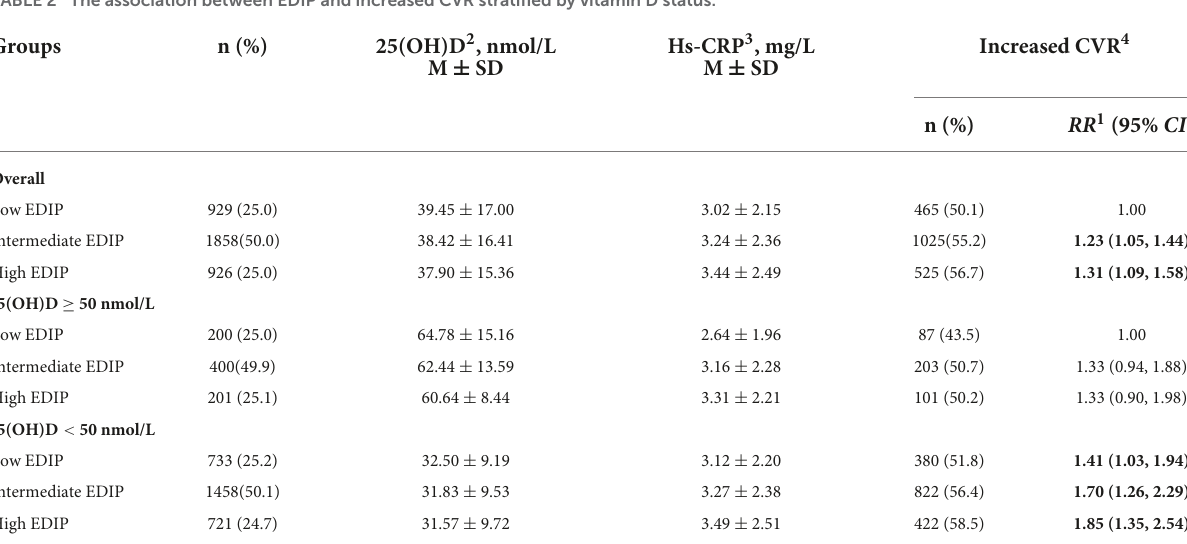
TABLE 2 The association between EDIP and increased CVR stratified by vitamin D status.